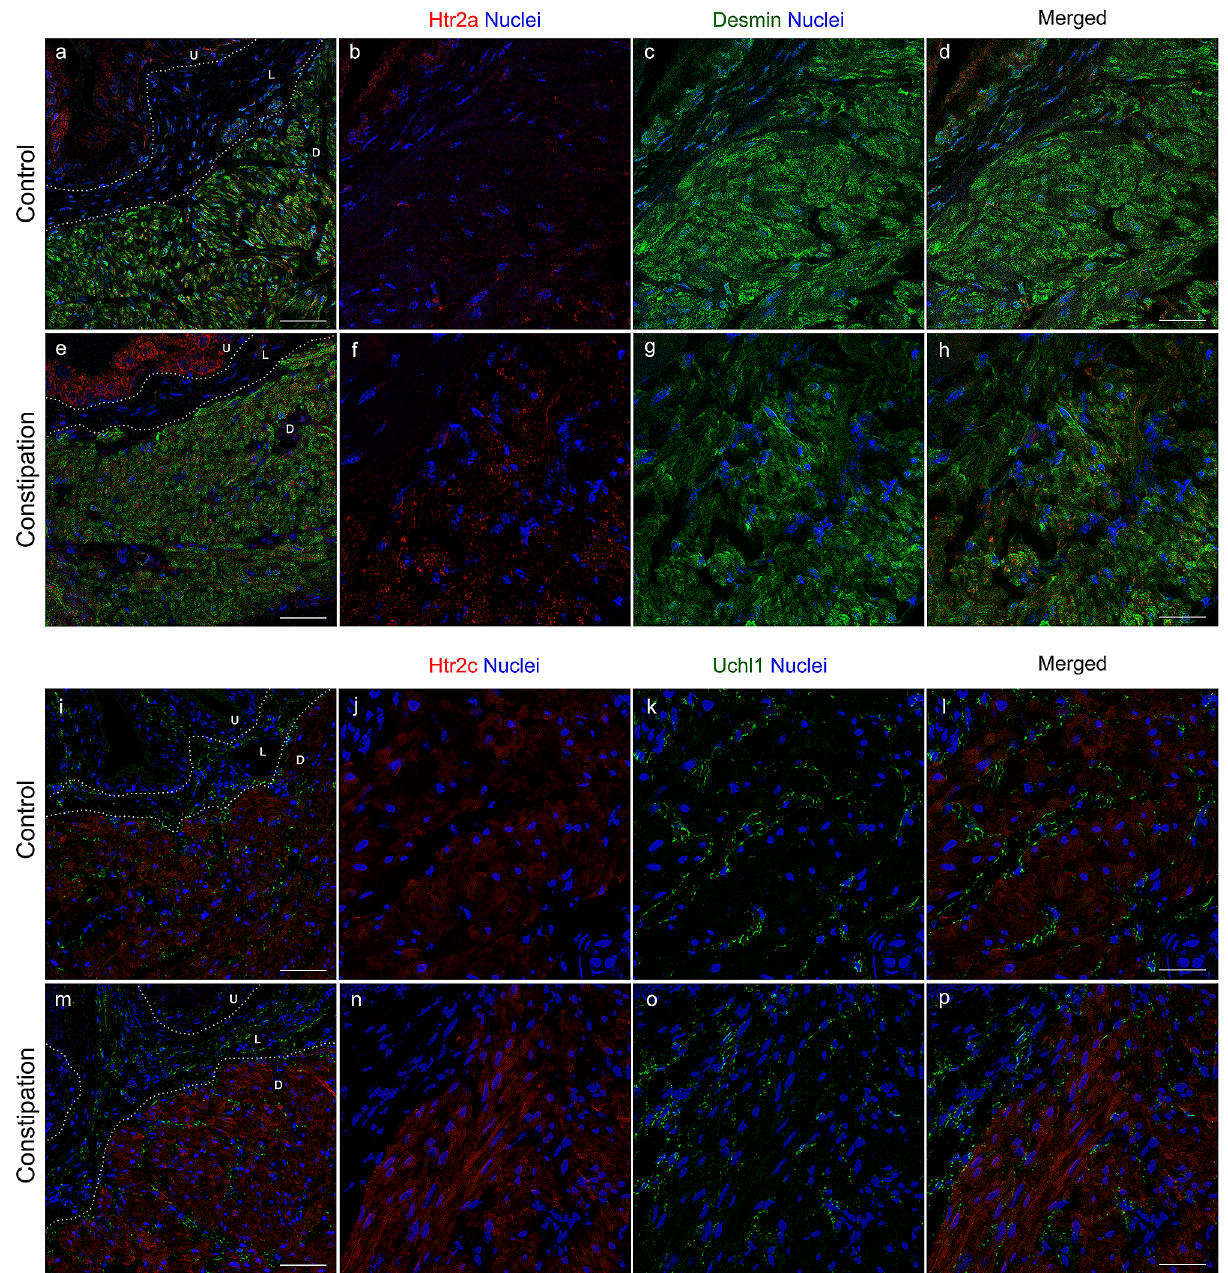
Figure 6. Distribution of Htr2a and Htr2c in the bladders. Representative immunohistochemical images with antibodies against Htr2a (red) and Desmin (green) ( a – h ), or Htr2c (red) and Uchl1 (green) ( i – p ) along nuclei staining using DAPI (blue). U, urothelia, L, lamina propria, and D, detrusor muscle layers. Bars, 100 µm ( a , e , i and m ) and 25 µm ( d , h , l and p ). Figures were prepared using Adobe Photoshop